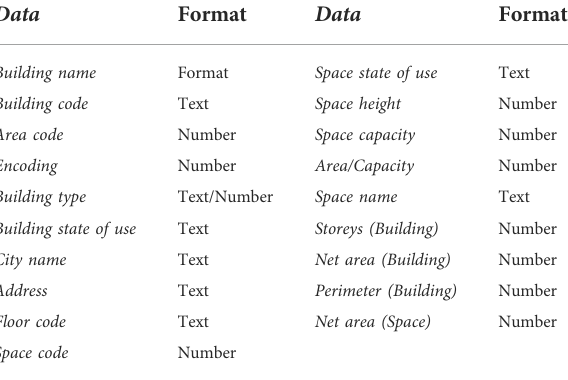
TABLE 2 Spatial attributes available from the Opensipi